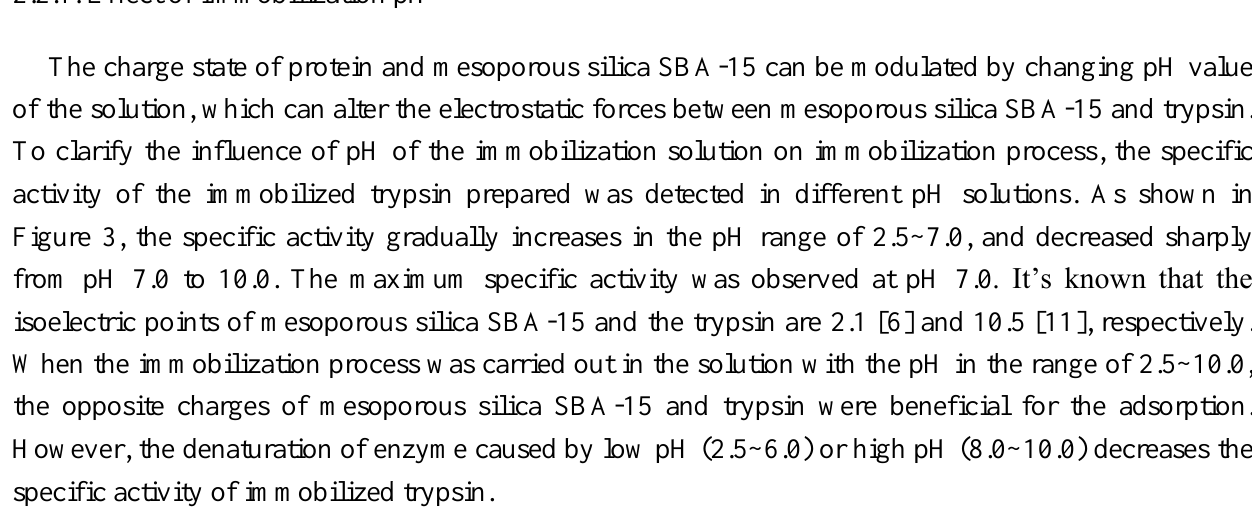
Figure 3. Effect of pH on the specific activity of immobilized